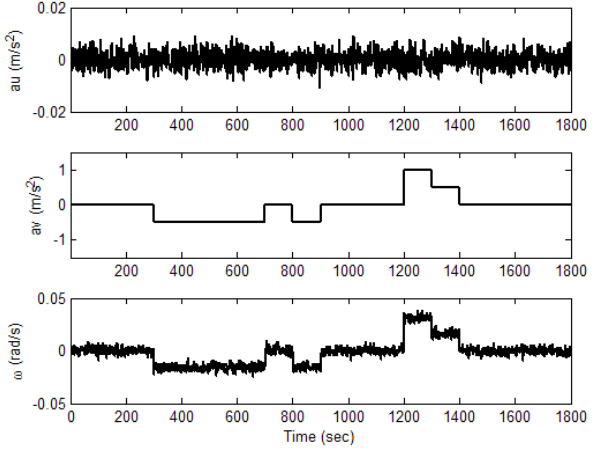
Figure 6. Simulated sensor outputs for the accelerometers and gyroscope.